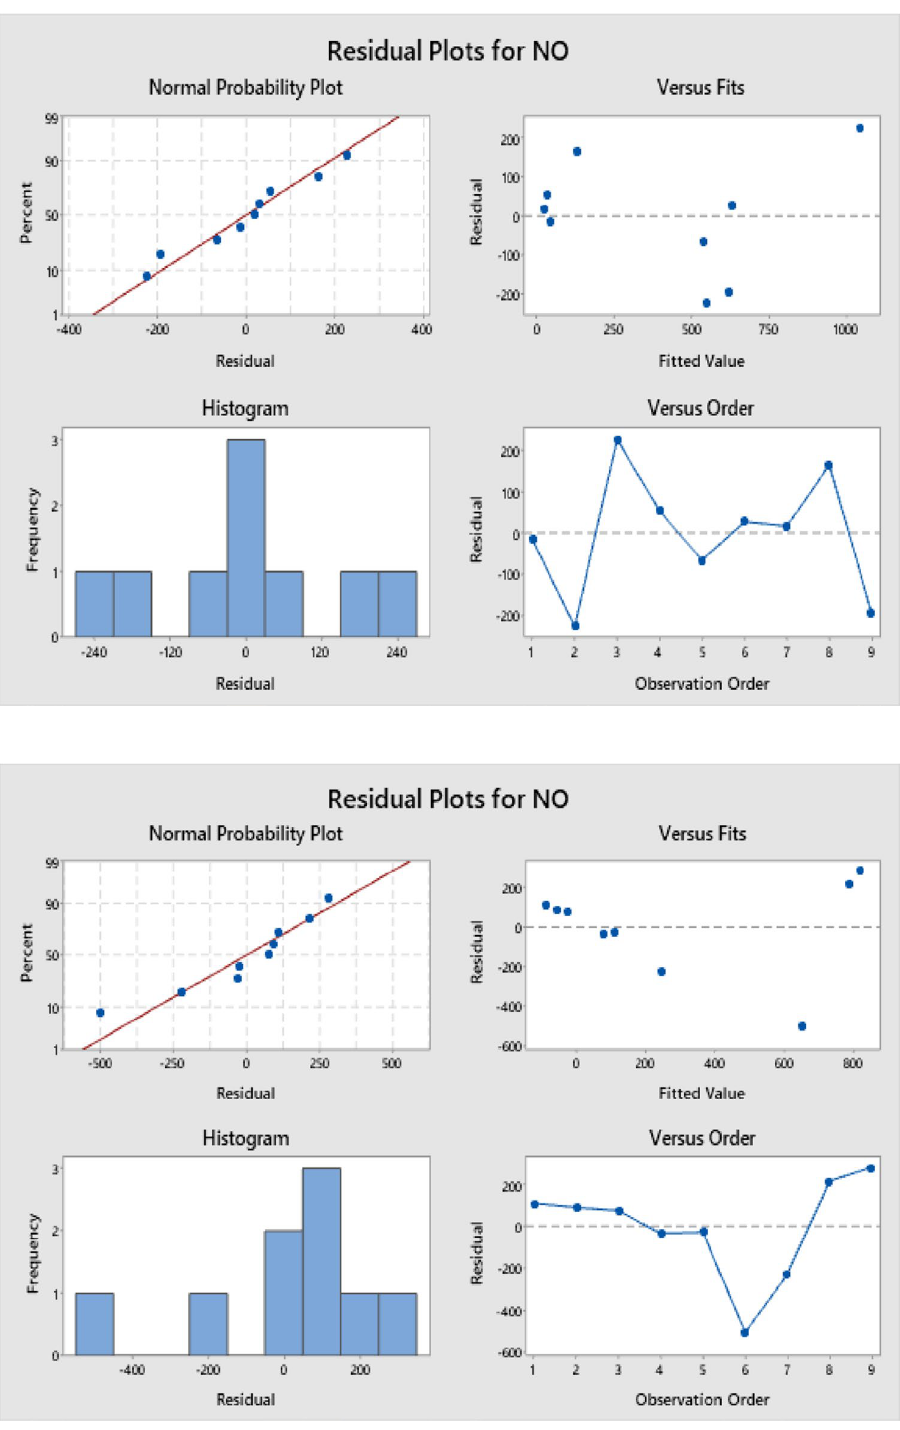
Fig. 22 Residual plot for NOx without nanoparticles